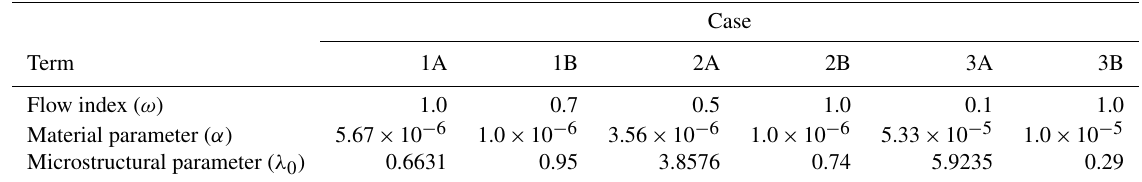
Table 3. Parameters of the time-dependent fluid model for thixotropic avalanche simulations using method A and method B for setting values.